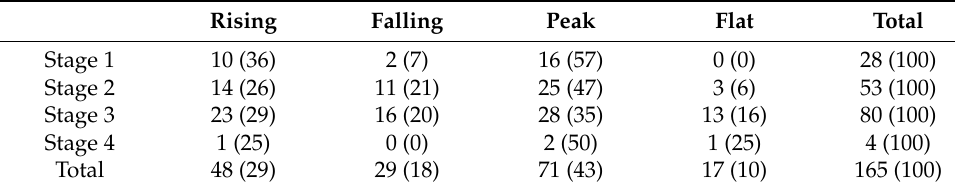
Table 2. The number and proportion of each stage and curve type (n